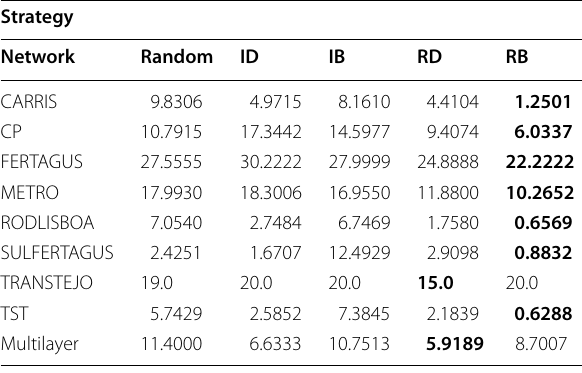
Table 3 Normalized AUC across all networks: RB is the most effective node removal strategy in all the networks, with the exception of TRANSTEJO and the multilayer network